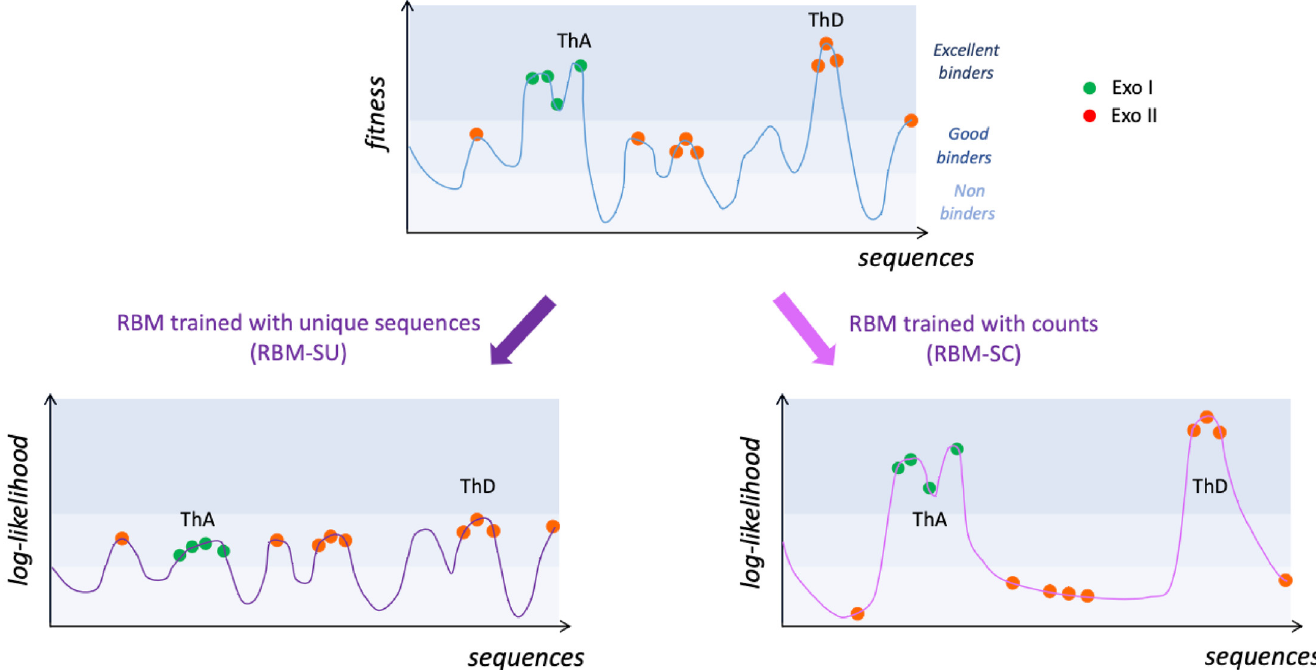
Fig 9. Sketches of the fitness and inferred landscapes. Top: fitness of the aptamer sequences as estimated by the SELEX experiment. After some rounds of selection, most sequences are good binders to thrombin and have low counts (very often, C = 1), while some are excellent binders and have large counts. Two excellent binders, ThA and ThD, are schematically shown. Bottom: log-likelihood landscapes defined by the RBM models, trained from unique sequences (RBM-SU, left) or taking into counts (RBM-SC, right). RBM-SU is able to capture the statistical features of the many good binders, but does not reproduce well the few high-fitness peaks. It can be used to generate new sequences (empty peak in the landscape). Conversely, RBM-SC accurately models the high peaks in the fitness landscape, but is unable to reproduce the detailed structure of the landscape at lower levels. It cannot be used to generate new binders.